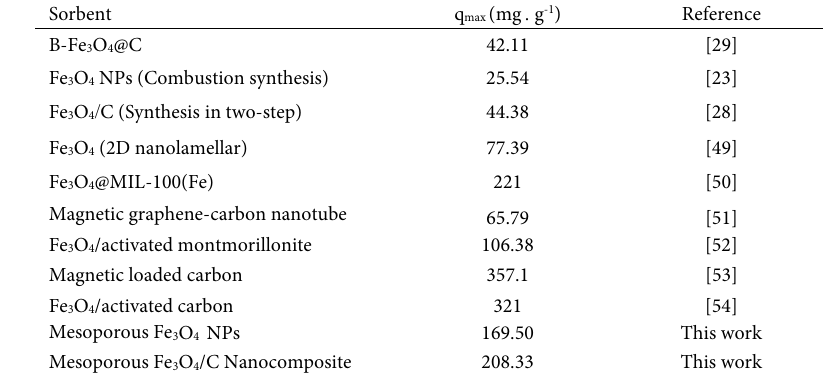
Table 5: Comparing of the proposed adsorbent with several recently reported magnetic adsorbents for MB removal